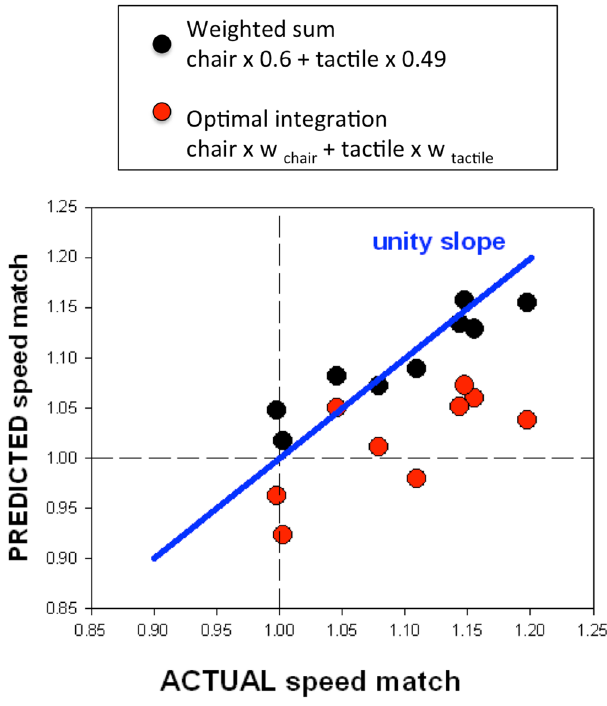
Figure 3. Shows the predicted speed match for each participant based on the optimum integration model fit for each participant (red symbols). The black symbols are the predicted combined speed based on an unconstrained weighted sum model. The solid line has a slope of unity, which would indicate a perfect